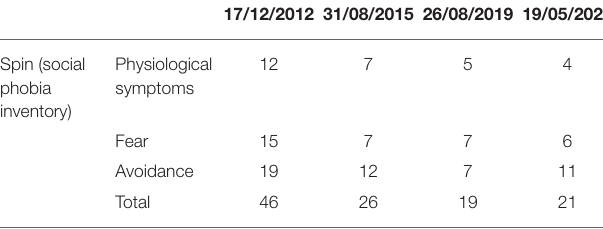
TABLE 1 | Change in anxiety